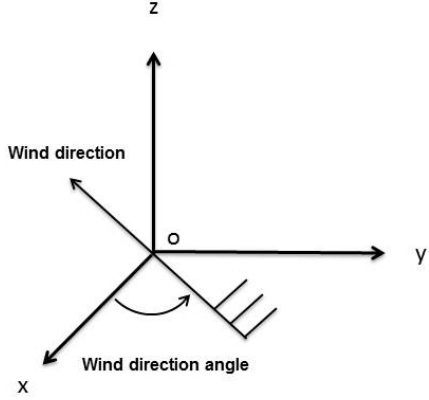
Fig. 3. Geometry of wind direction in the coordinate